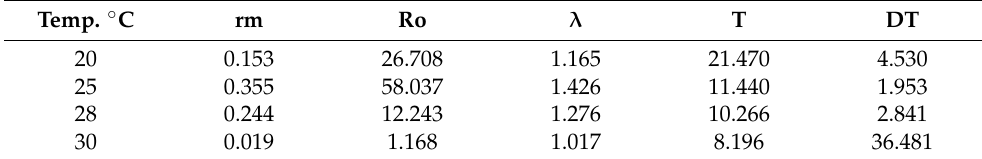
Table 2. Life table parameters describing Phorodon cannabis as a function of temperature. Ro = net reproductive rate; rm = intrinsic rate of increase; λ = finite rate of increase; T = generation time; DT = doubling time Temp. °C